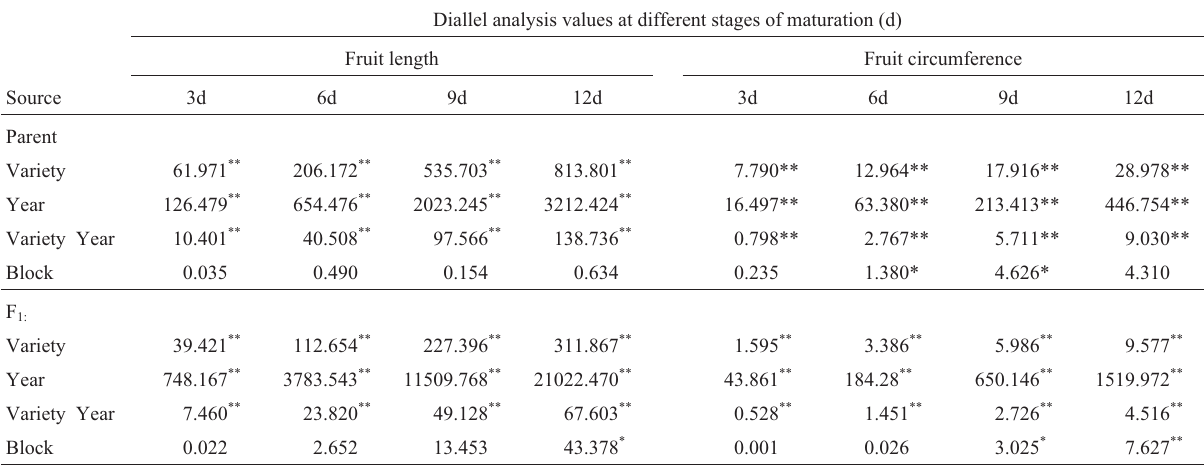
Table 1 - Analysis of variance (ANOVA) of the mean square diallel analysis of sponge gourd ( Luffa cylindrical (L) Roem.) fruit length and circumfer- ence at different stages of maturation. Diallel analysis values at different stages of maturation (d) Fruit length Fruit circumference